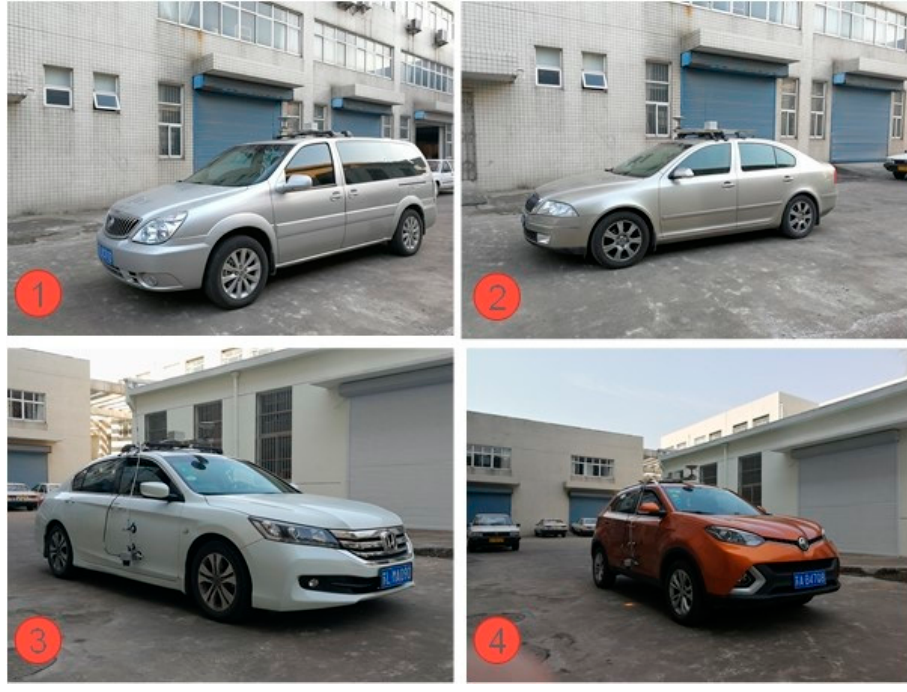
Figure 2. Experimental vehicles ( 1 ) GM GL8, ( 2 ) Skoda Octavia, ( 3 ) Honda Accord, ( 4 ) SAIC MG.